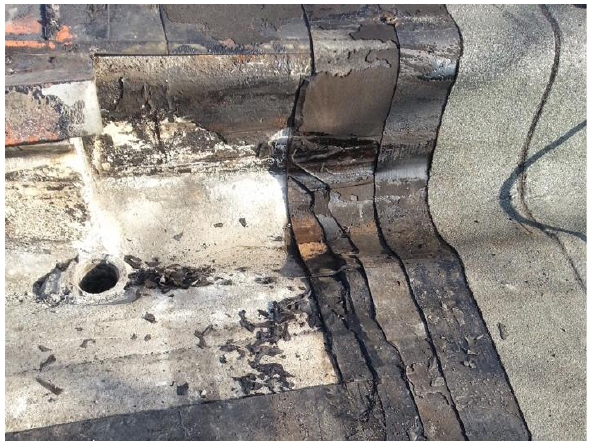
Figure 4. Non-accessible roof (Ambrosini’s photo,